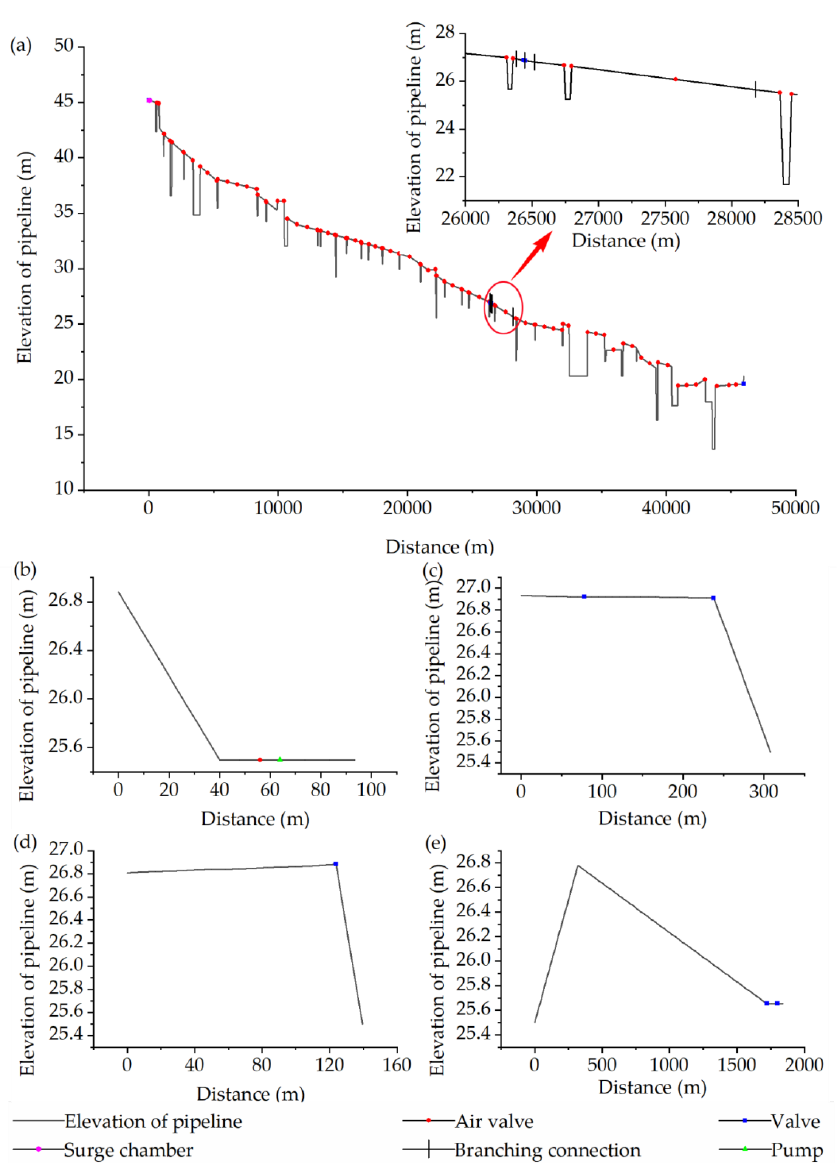
Figure 2. A longitudinal profile of ( a ) the pipeline of Beijing and Hebei province; ( b ) the branch to regulating tank of the pipeline ① ; ( c ) the pipeline ④ ; ( d ) the branch to regulating tank of the pipeline ② ; (e) the pipeline ③ and the location of the air valves, pumps, valves, and surge chamber.